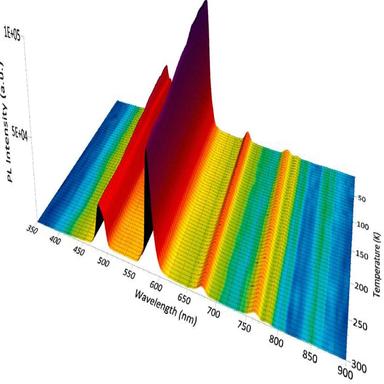
(a) Variation of PL spectrum of ZrO2:0.004Dy3+, 0.07K+ phosphor sample with temperature (b) PL spectra at 300 K and 50 K.